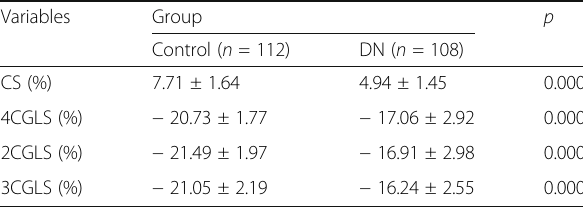
Table 3 Comparison of STE